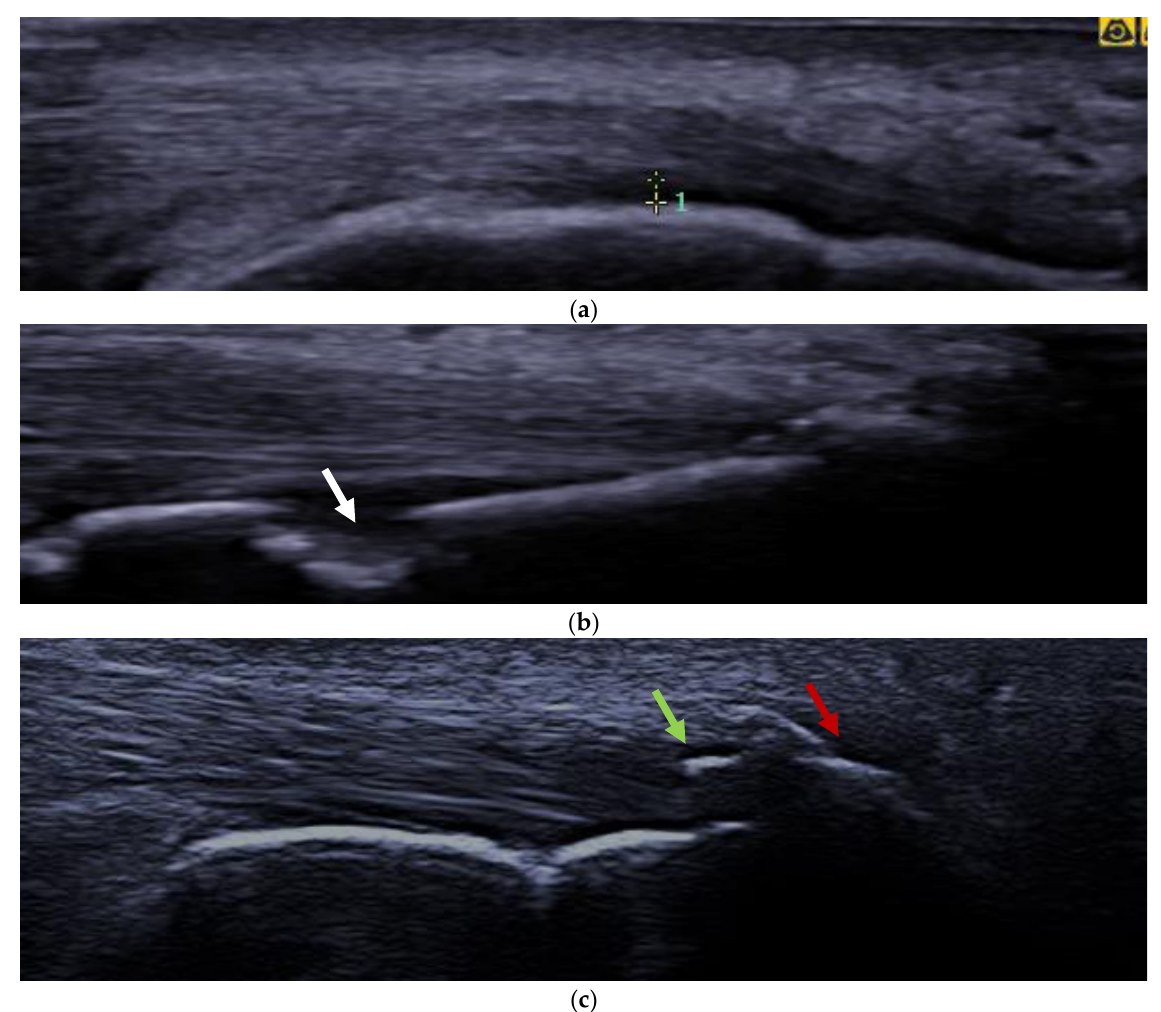
Figure 1. ( a ) Measure of EF thickness at Achilles tendon insertion. ( b ) Erosion (white arrow) at Achilles tendon insertion in a PsA patient. ( c ) Enthesophyte (red arrow) and calcification (green arrow) at Achilles tendon in athletes.